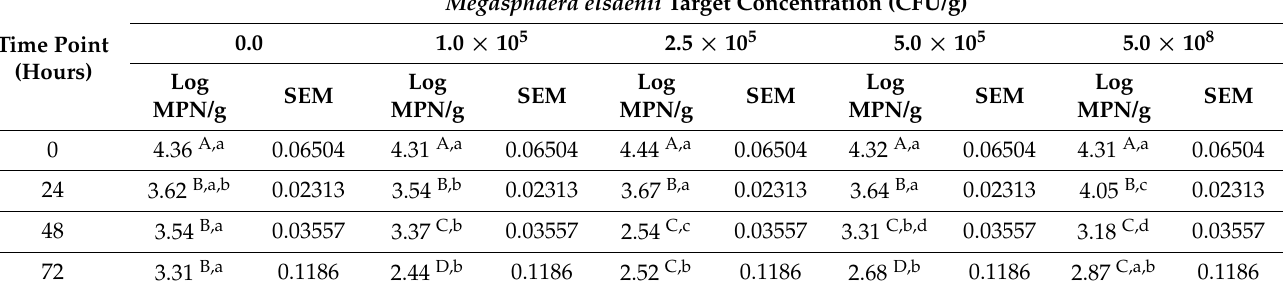
Table 3. Mean concentration (log 10 MPN/g) of susceptible Salmonella concentration in inoculated cat- tle feces at 0, 24, 48, and 72 h following treatment with varying concentrations of Megasphaera elsdenii as an in vitro model.